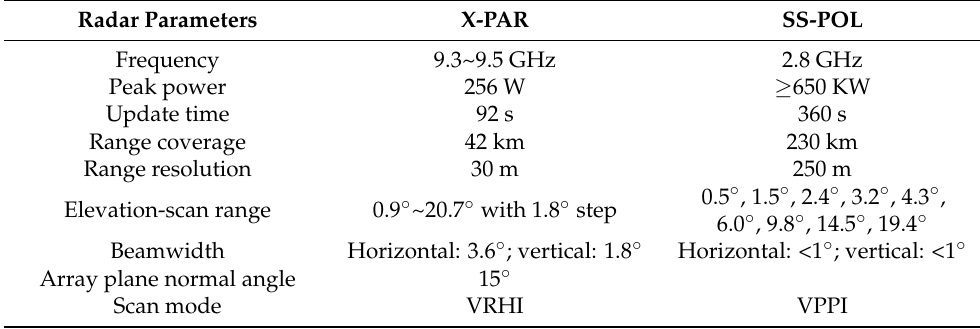
Table 1. X-PAR and S-POL radar